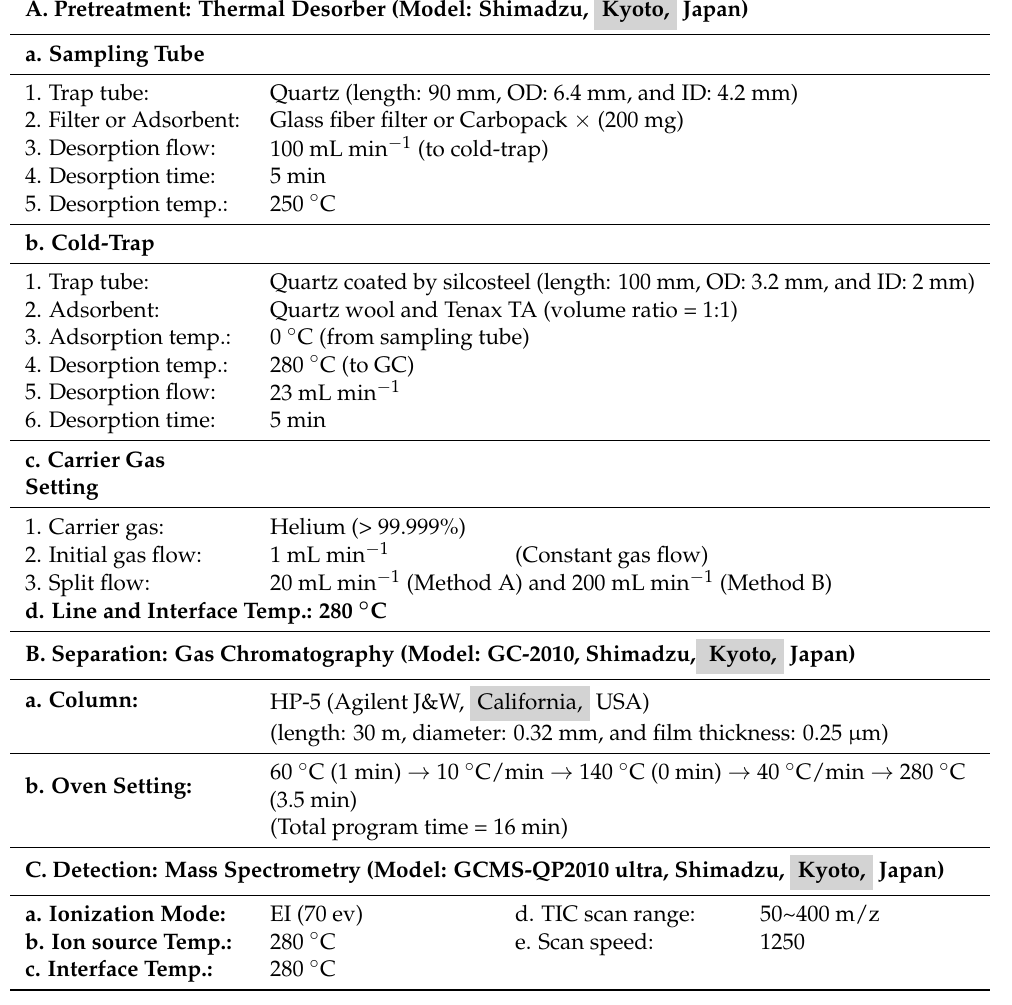
Table 3. Operational conditions for analysis of MIT and CMIT in